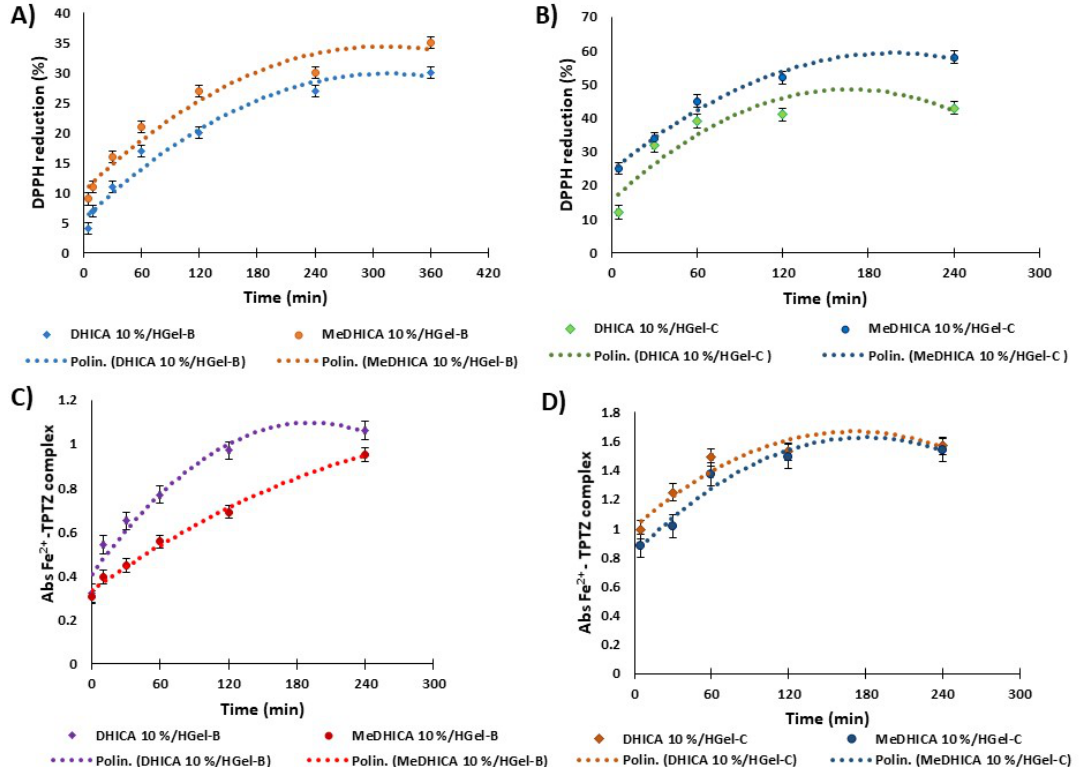
Figure 10. 2,2-diphenyl-1-picrilhydrazyl (DPPH) reduction properties of DHICA or MeDHICA 10% HGel-B (panel A ) and 10% HGel-C (panel B ) over time; increase of the absorbance at 593 nm due to the Fe 2+ TPTZ complex induced by DHICA or MeDHICA 10% HGel-B (panel C ) and 10% HGel-C (panel D ). Reported are the mean ± SD values of three experiments and the polynomial regression that fits the data.